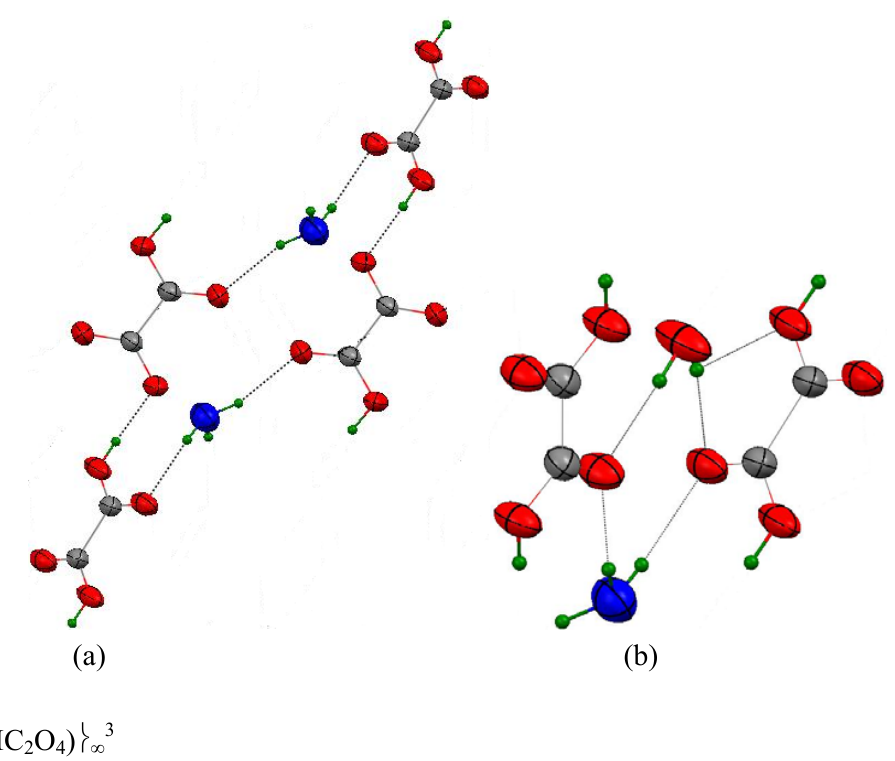
Figure 4. (a)The centrosymmetrical hydrogen-bonded motif, with graph notation R 66 (22), (b)The homosynthon, with graph notation R 42 (8) in compound